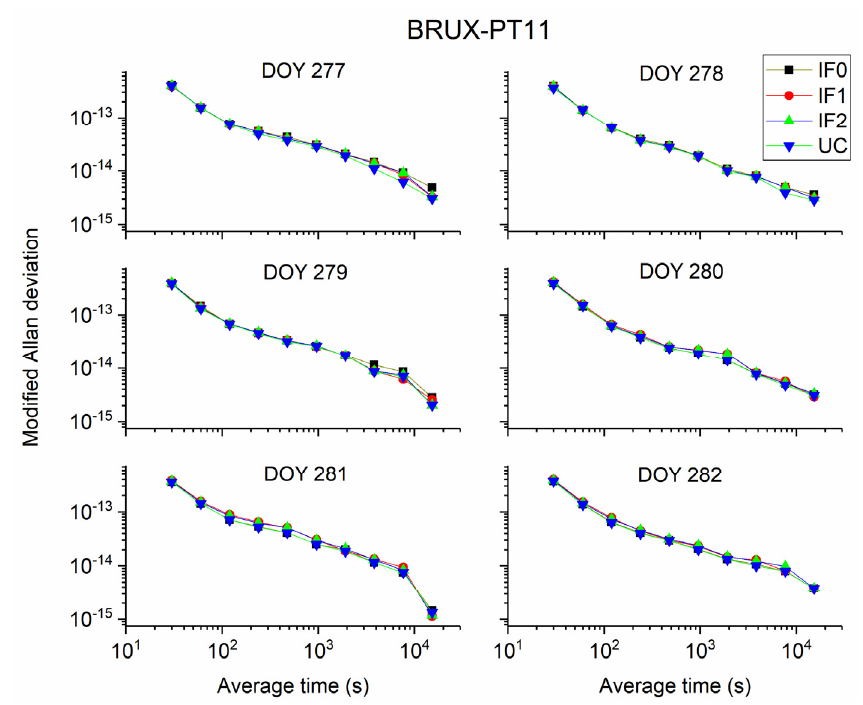
Figure 11. Comparison of MDEV between different Galileo PPP models for BRUX-PT11.